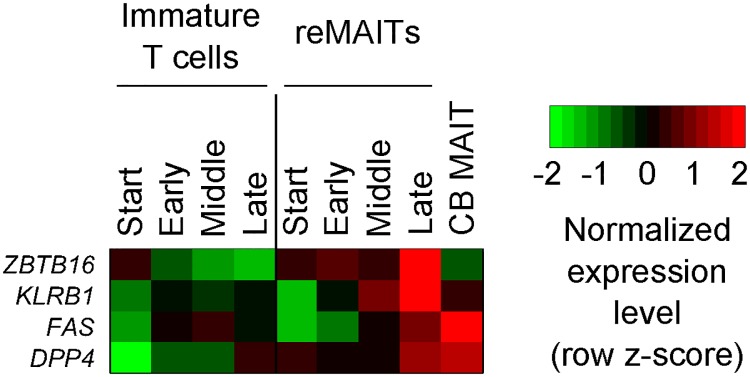
Differential expression of MAIT marker genes.Normalized gene expression levels for the markers of MAITs. Differentially expressed markers (limma, P < 0.05) are shown. See S2 Table for the complete list. Marker gene information is obtained from [5].